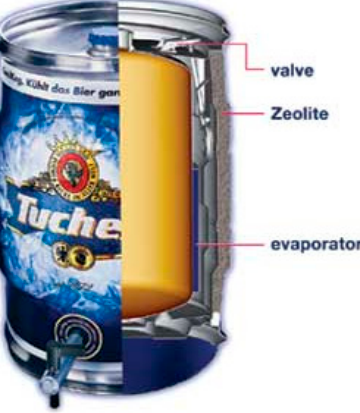
Figure 8. A small beer barrel with embedded adsorption TES for cooling. Courtesy of Cool-System (figure adapted from [19] with permission of Springer, 2007).